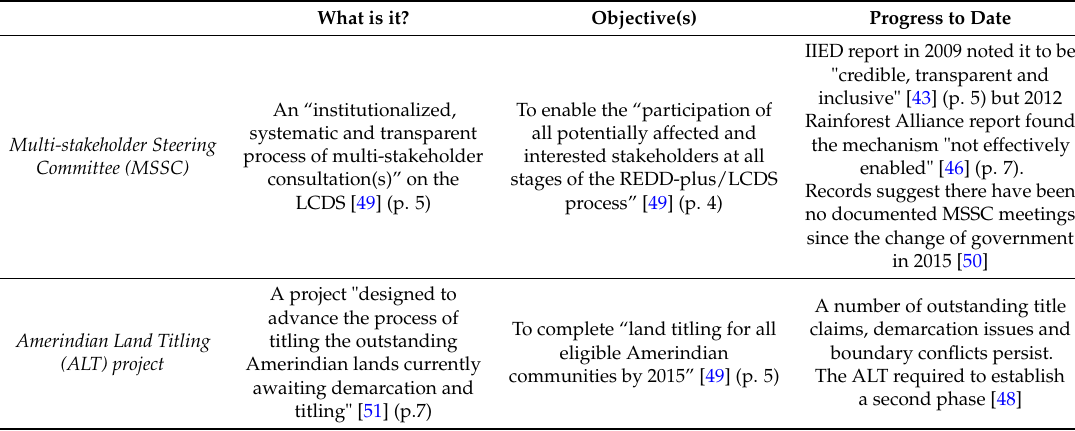
Table 1. Outline of Amerindian relevant projects within the LCDS